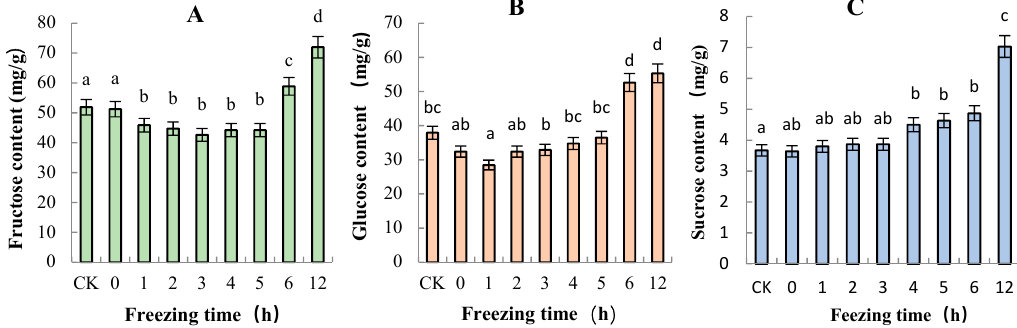
Figure 6. Changes in soluble sugar ( A : fructose, B : glucose, C : sucrose) content in “Ruaner” pear during the freezing–thawing stage. Different letters indicated significant differences between thawing time treated and control (Duncan’s multiple range test, p < 0.05).